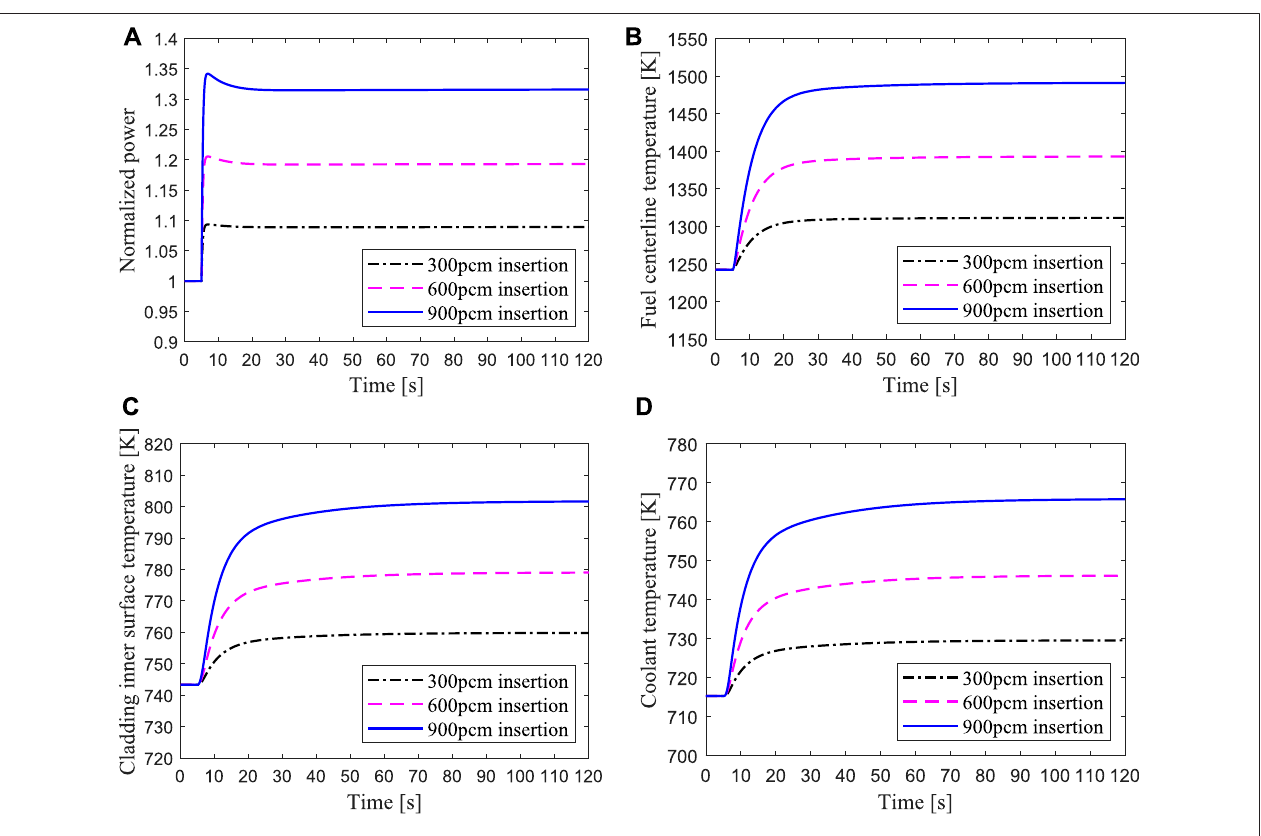
FIGURE 11 | Transient responses of the hottest channel for unprotected reactivity insertions of 300, 600, and 900 pcm respectively.